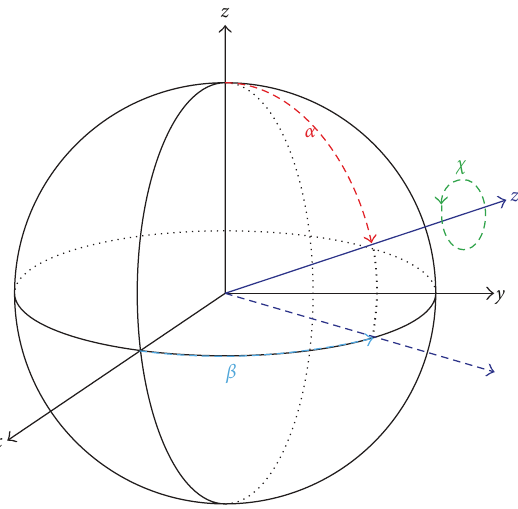
Figure 2: There are three degrees of freedom in the specification of a rotation to an arbitrary orientation. The diagram defines a rotation of an object in 3D via Euler angles. The object is rotated by an angle α in the direction β and subsequently rotated by an angle χ about the axis z (cid:5) defined by ( α , β